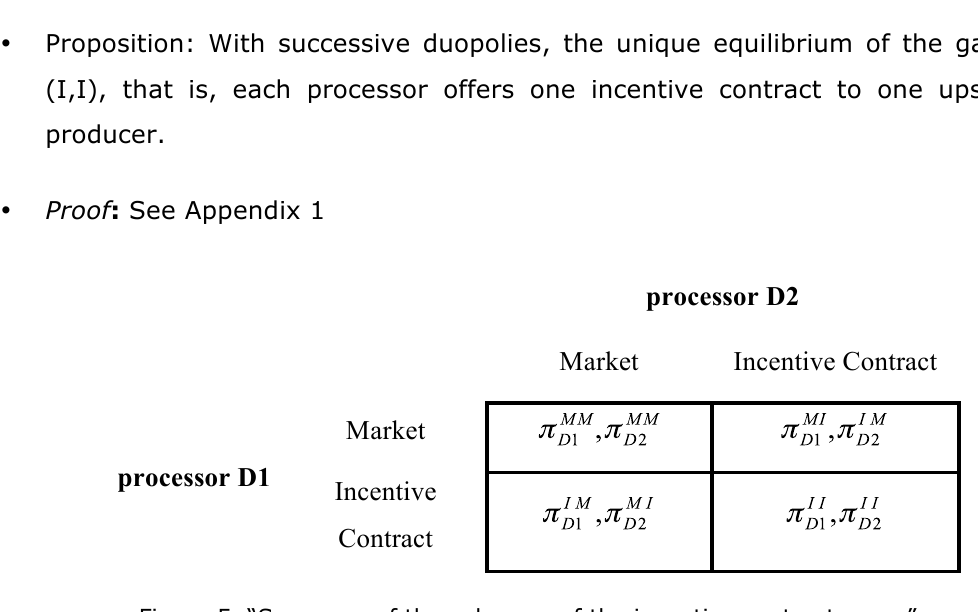
Figure 5. “Summary of the subgame of the incentive contract